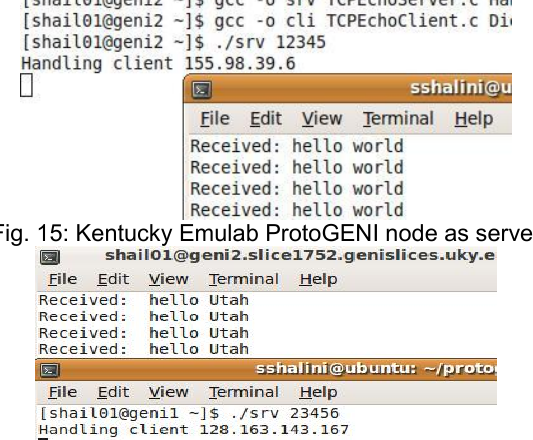
Fig. 16: Utah Emulab ProtoGENI node as